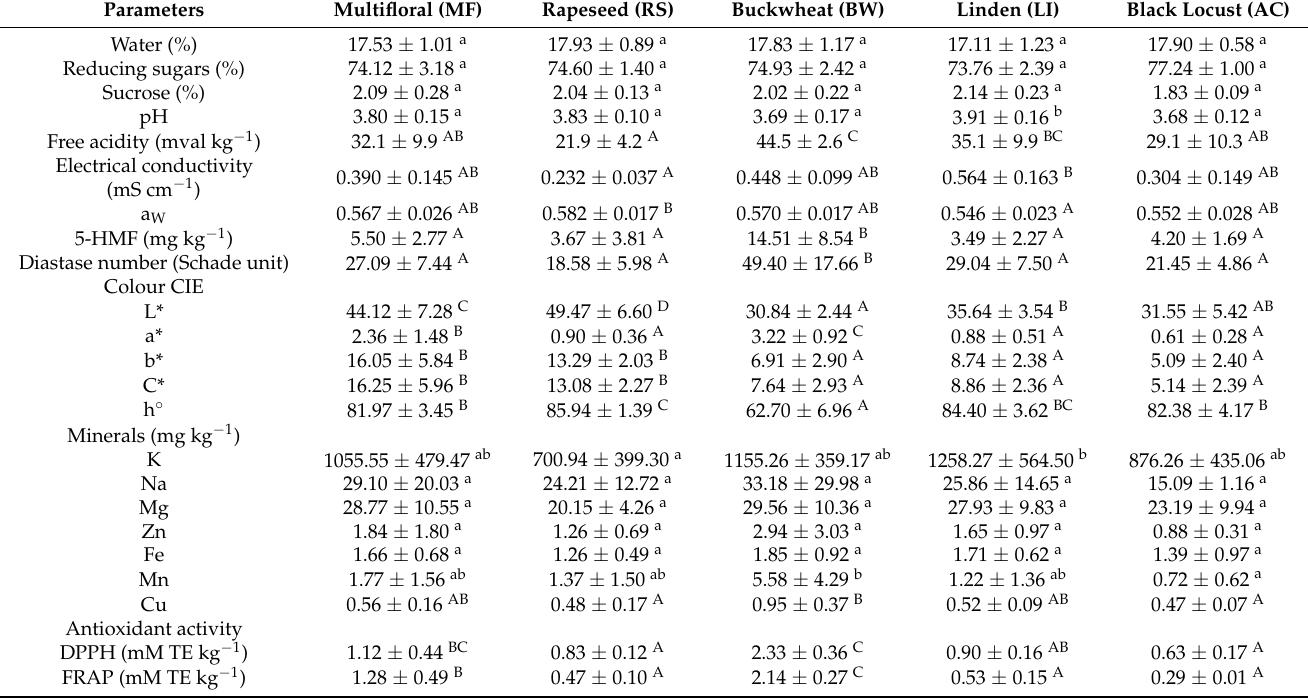
Table 1. Parameters of physicochemical traits and antioxidant activity of the honey types (mean values ± standard